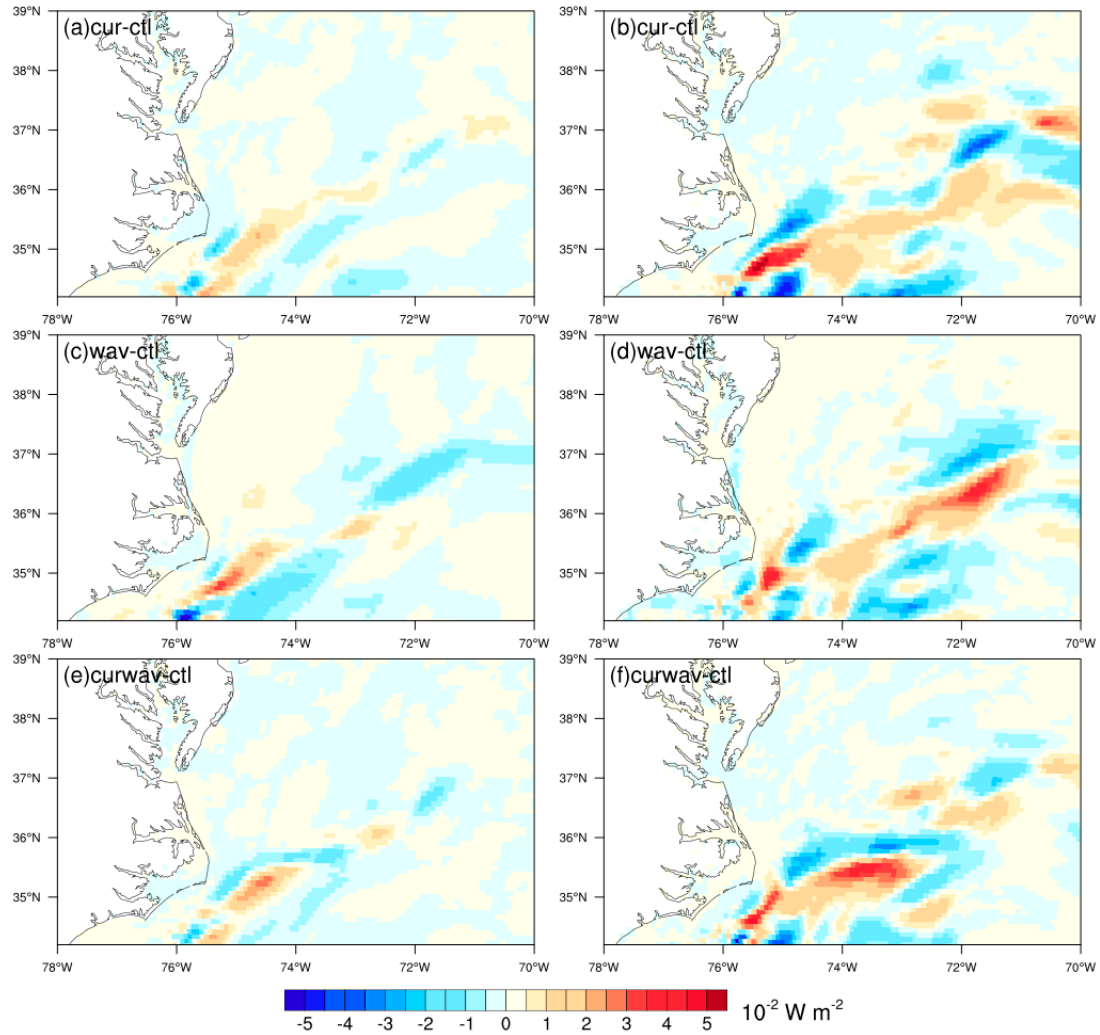
Figure 14. 30 day averaged differences of mean (left column) and eddy (right column) components of the wind work between ( a , b ) CUR and CTL, ( c , d ) WAV and CTL, and ( e , f ) CUR_WAV and CTL.